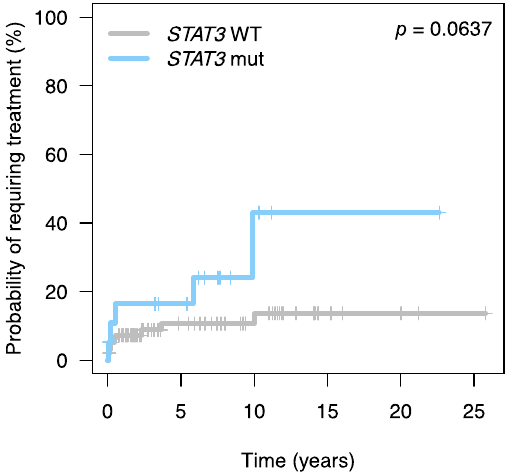
Figure 1. Time to first treatment according to mutational status of STAT3.